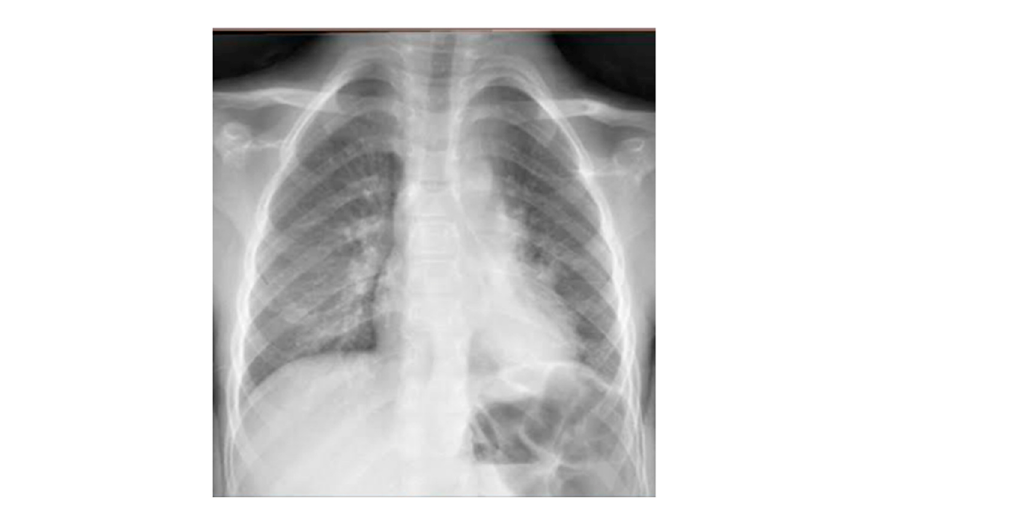
Figure 2. Chest radiography shows, on the left inferior lobe, non-specific areas of reduced transparency, associated with obliteration of the left lateral costophrenic sinus. It shows further subtle parenchymal hypodiaphania on the right mid-basal area.